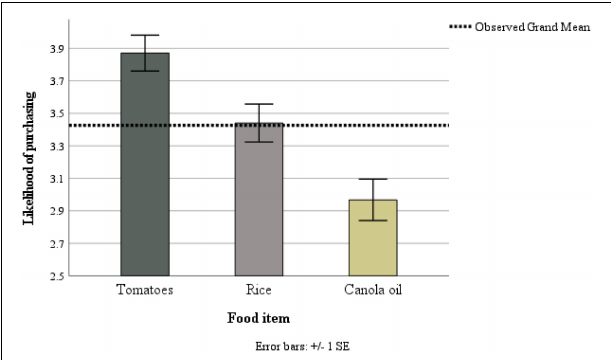
FIGURE 3 | Means (SDs in Parentheses) for the intention to purchase the three presented foods bred through different technologies. Results of Greenhouse-Geisser corrected